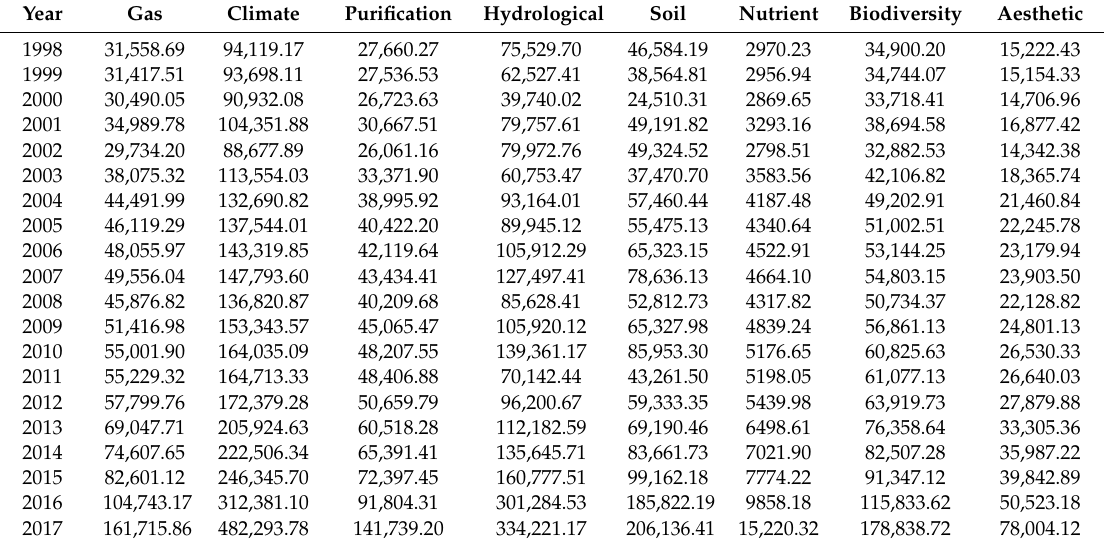
Table A7. Indirect economic losses from disease in Mainland China from 1998 to 2017 (Tertiary indicator) / 10 4